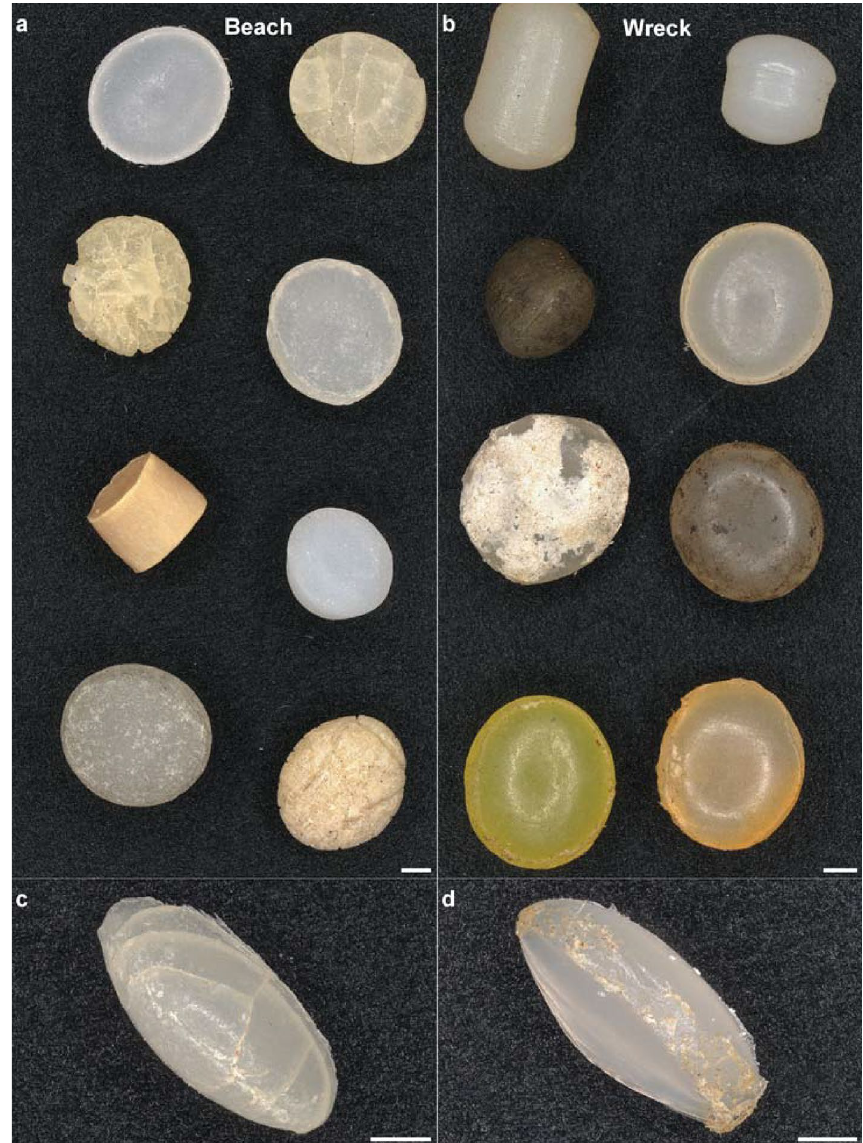
Figure 3. Light microscopic images of MP resin pellets from a beach in the Wadi el Gemal national park, Egypt, and the SS Hamada wreck in the Red Sea. Representative overview of different particle shapes and colors of MP from ( a ) the beach and ( b ) the SS Hamada wreck. The proportion of this properties varied within the sample, in which beige, white, and grey disk-like pellets were more frequent than yellow, black, red, or cylindrical particles (c.f. Supplementary Fig. S2 online and Supplementary Fig. S3 online). A complex network of cracks was only present on beached MP. Side views of particle surface revealed a lower level of abrasion for ( c ) MP from the beach compared to ( d ) the wreck. Scale bars: 1